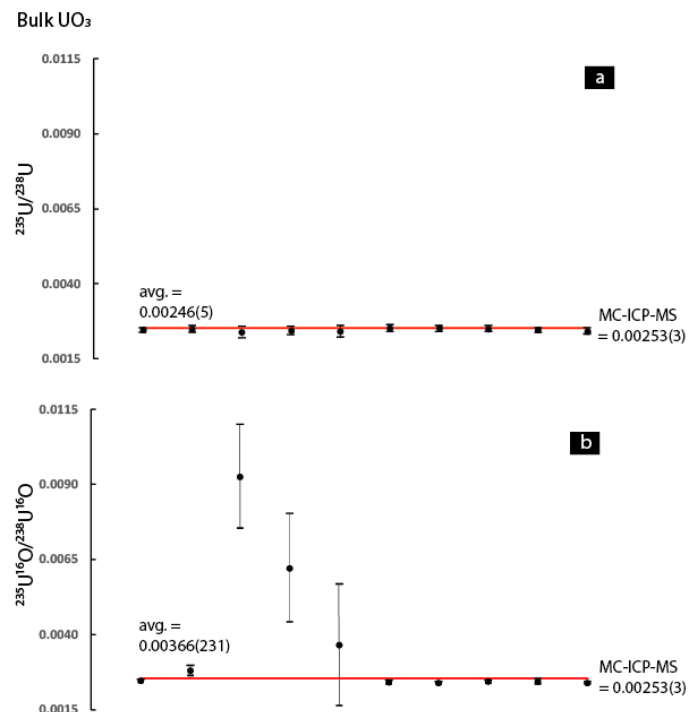
Figure 6. Plot of each analysis’s ( a ) 235 U / 238 U and ( b ) 235 U 16 O / 238 U 16 O ratio and its associated 1 σ uncertainty relative to the solution MC-ICP-MS value (red line) for the and UO 3 analyzed using the 200 pA primary beam current.